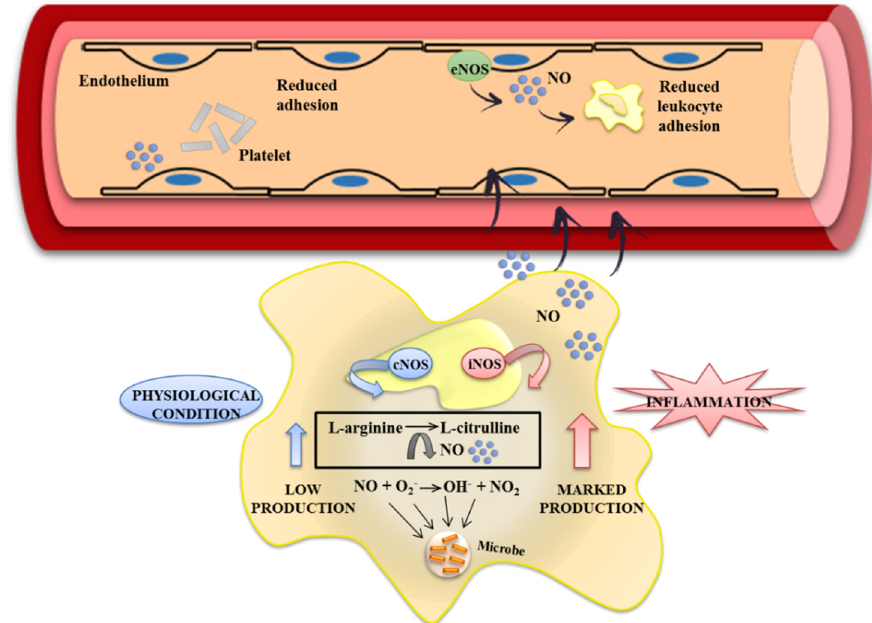
Figure 3. Nitrite oxide (NO) is a free radical molecule generated from L ‐ arginine oxidation, and